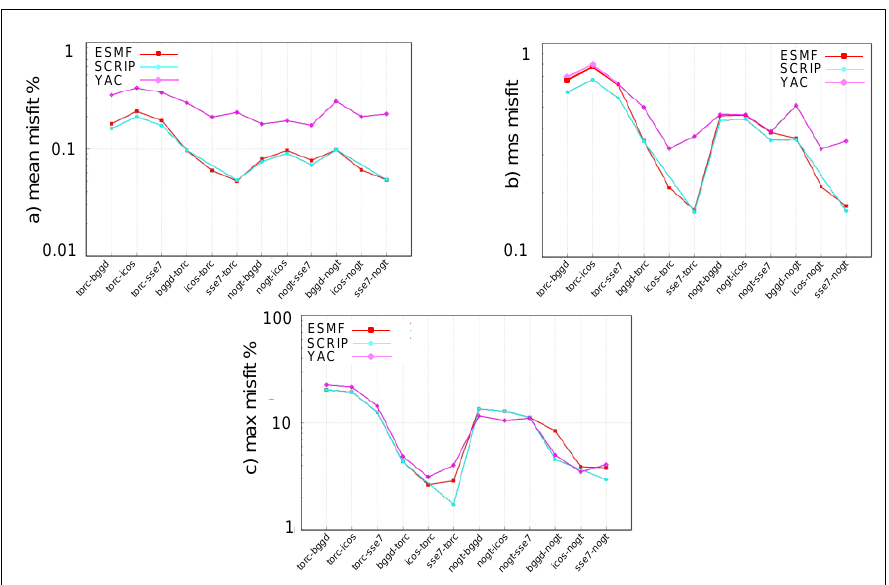
Figure 5. ( a ) mean, ( b ) rms, and ( c ) maximum misfit for the different pairs of grids for the vortex function for first-order non-conservative regridding for ESMF, SCRIP and YAC.